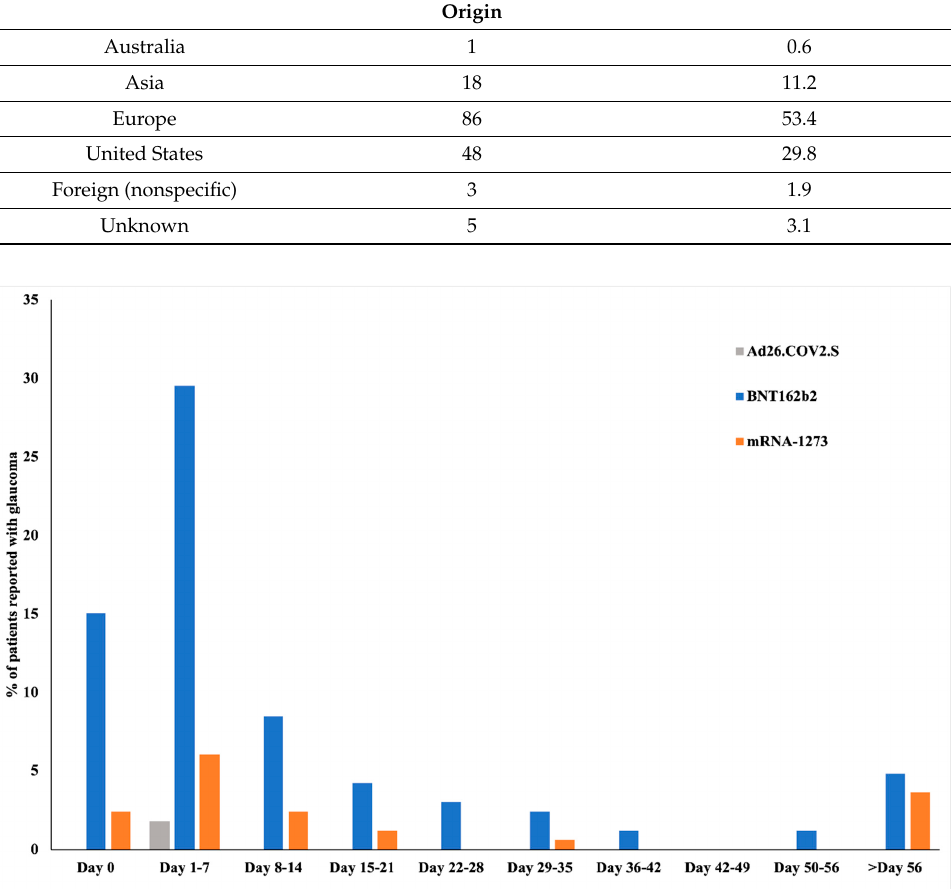
Figure 1. Cases of glaucoma following vaccination with BNT162b2, mRNA-1273, and Ad26.COV2.S on day 0 (i.e., day of vaccination) and in subsequent weeks. A total of 77 cases (47.8%) were reported after the first dose, 59 cases (36.6%) were reported after the second dose, and 13 cases (8.1%) were reported after the third dose of the vaccine (Figure 2). Only five patients (3.1%) reported a prior history of COVID-19. On ( n = 105, 65.2%) had OAG. The patients presented with ocular pain ( n = 60, 37.3%), re- duced/blurry vision (47.29.2%), and complete vision loss/blindness ( n = 35, 21.7%). An el- evated IOP was reported in 48 (29.8%) cases. The other ocular signs included flashes ( n = 6, 3.7%), floaters ( n = 5, 3.1%), and photophobia ( n = 5, 3.1%). Notably, 28 patients (17.3%)